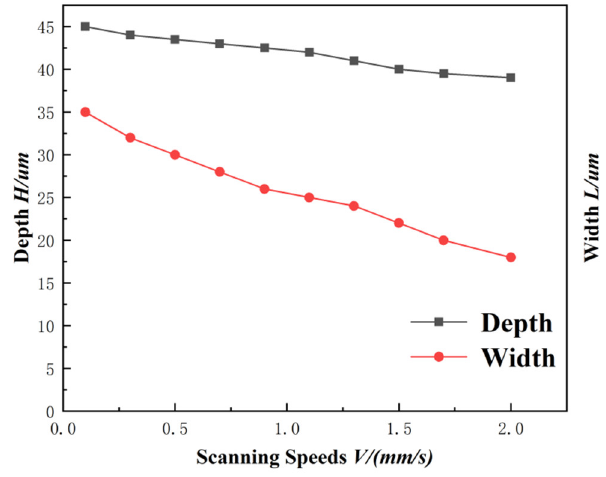
Figure 10. Variation curve of groove depth and width with scanning speed (laser energy is 10 μJ, scanning number is 1, repetition frequency is 40 kHz).